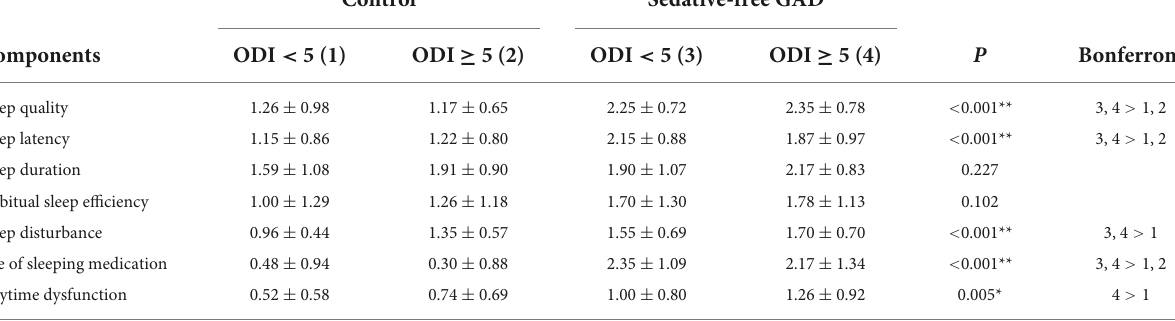
TABLE 3 Comparison of PSQI result by component and group.